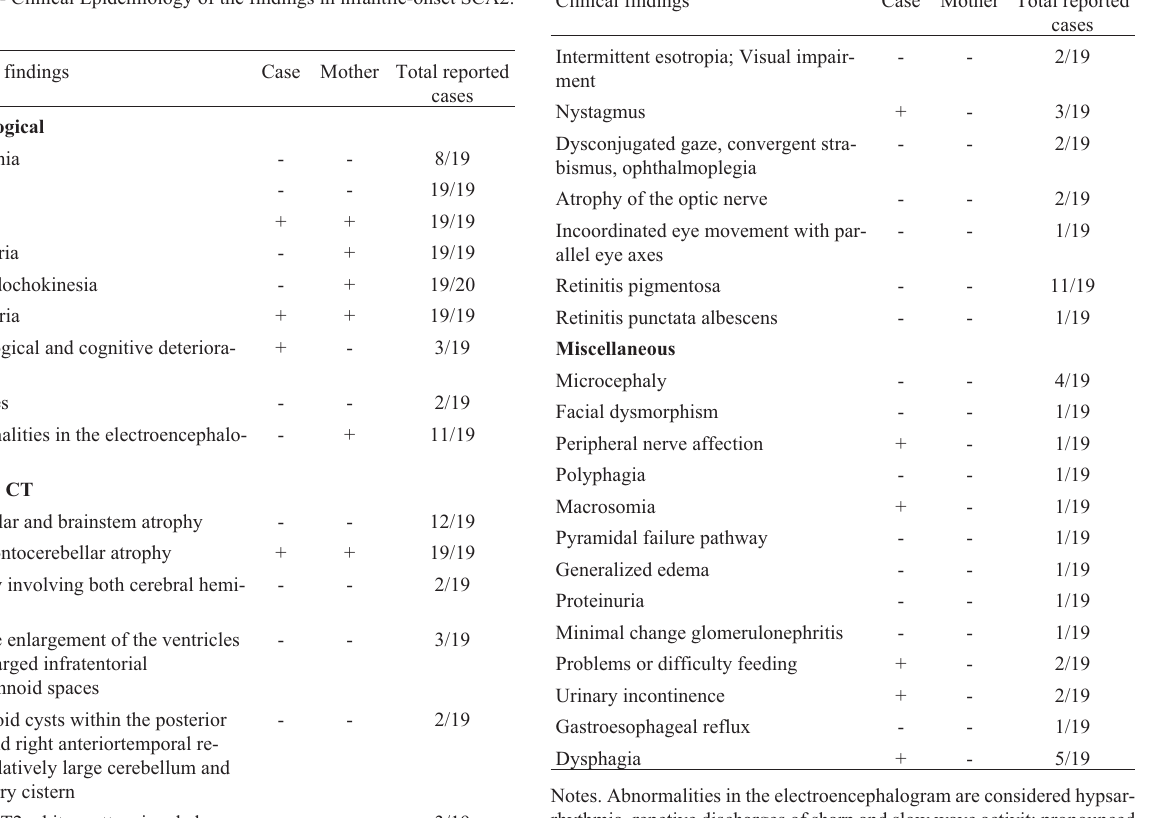
Table 2 - Clinical Epidemiology of the findings in infantile-onset